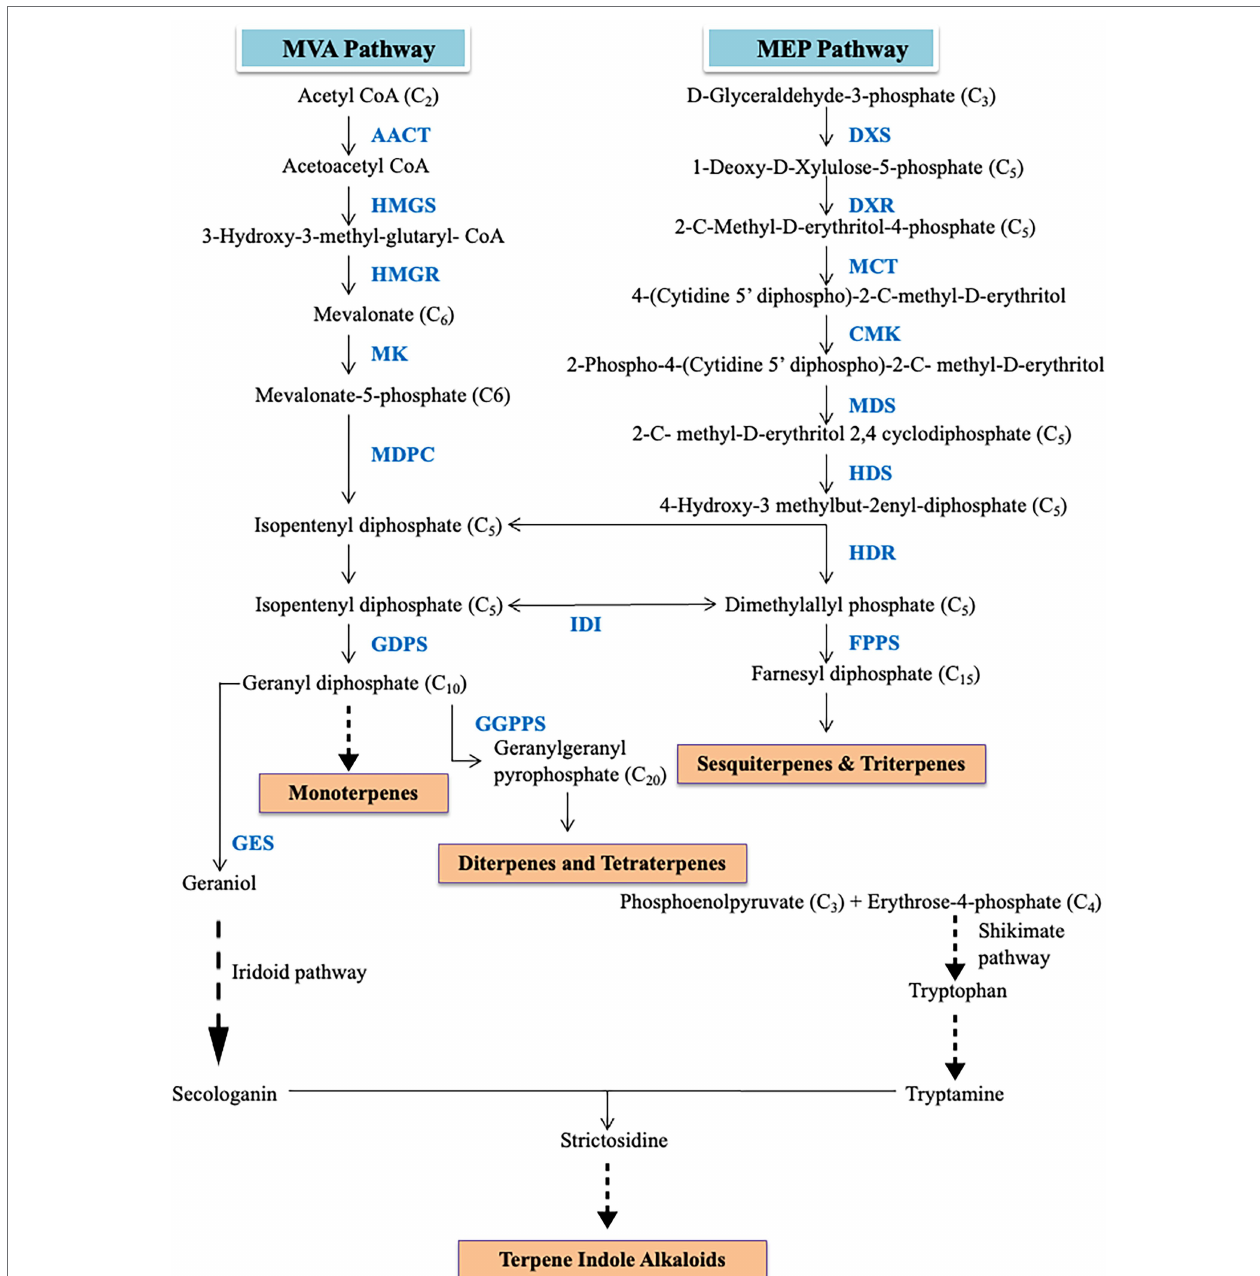
FIGURE 2 | Diagrammatic representation of methyl- d -erythritol 4-phosphate (MEP) and mevalonate (MVA)